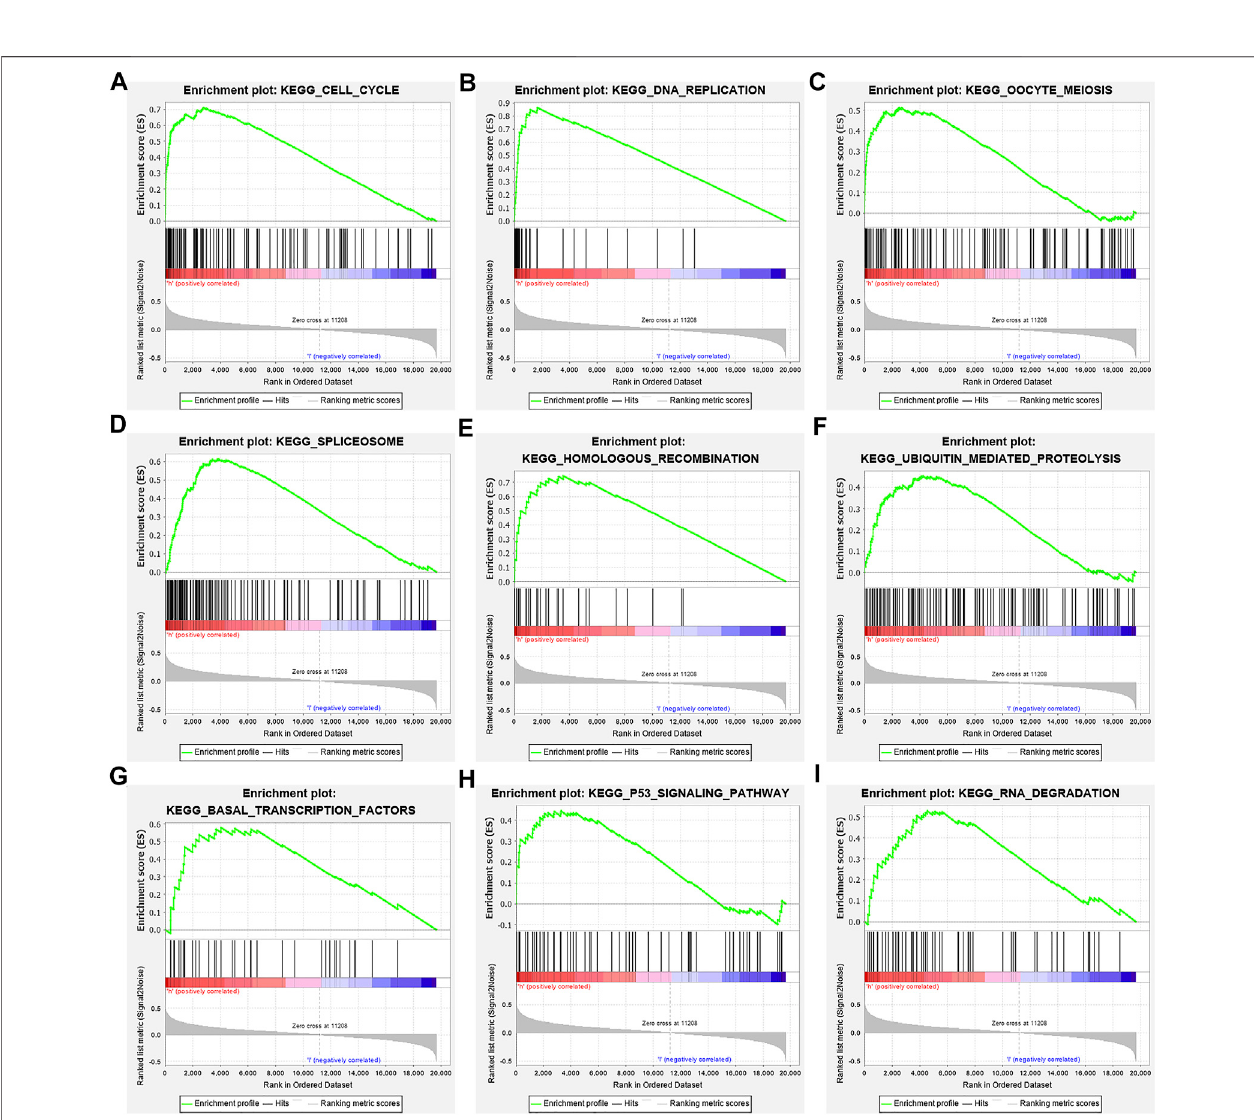
FIGURE 9 | Signaling pathways involved in the risk model via the GSEA. Note: GSEA, gene set enrichment analysis.